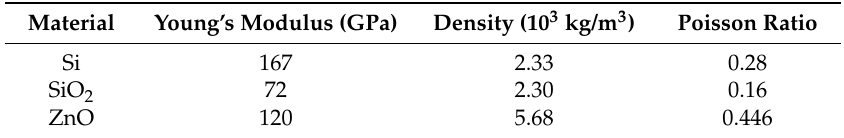
Table 2. Materials properties of